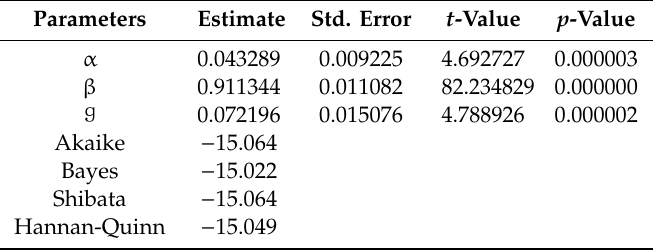
Table A3. Parameter Estimates of China’s Islamic-conventional ADCC-GARCH model. Table A1. Parameter Estimates of Hong Kong’s Islamic-conventional ADCC-GARCH model. Table A2. Parameter Estimates of New Zealand’s Islamic-conventional ADCC-GARCH model. Table A8. Parameter Estimates of Argentina’s Islamic-conventional ADCC-GARCH model. Parameters Parameters